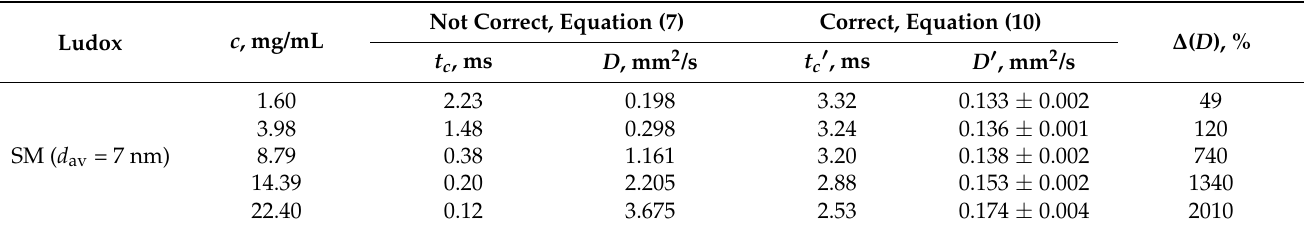
Table 4. Error in finding the characteristic time and thermal diffusivity, Equation (13), between using the averaging of the last 300 ms of the transient curve as a stationary state (parameters without apostrophe) and using the adjusted intensities of the probe beam in the stationary state (parameters with apostrophe, true value).